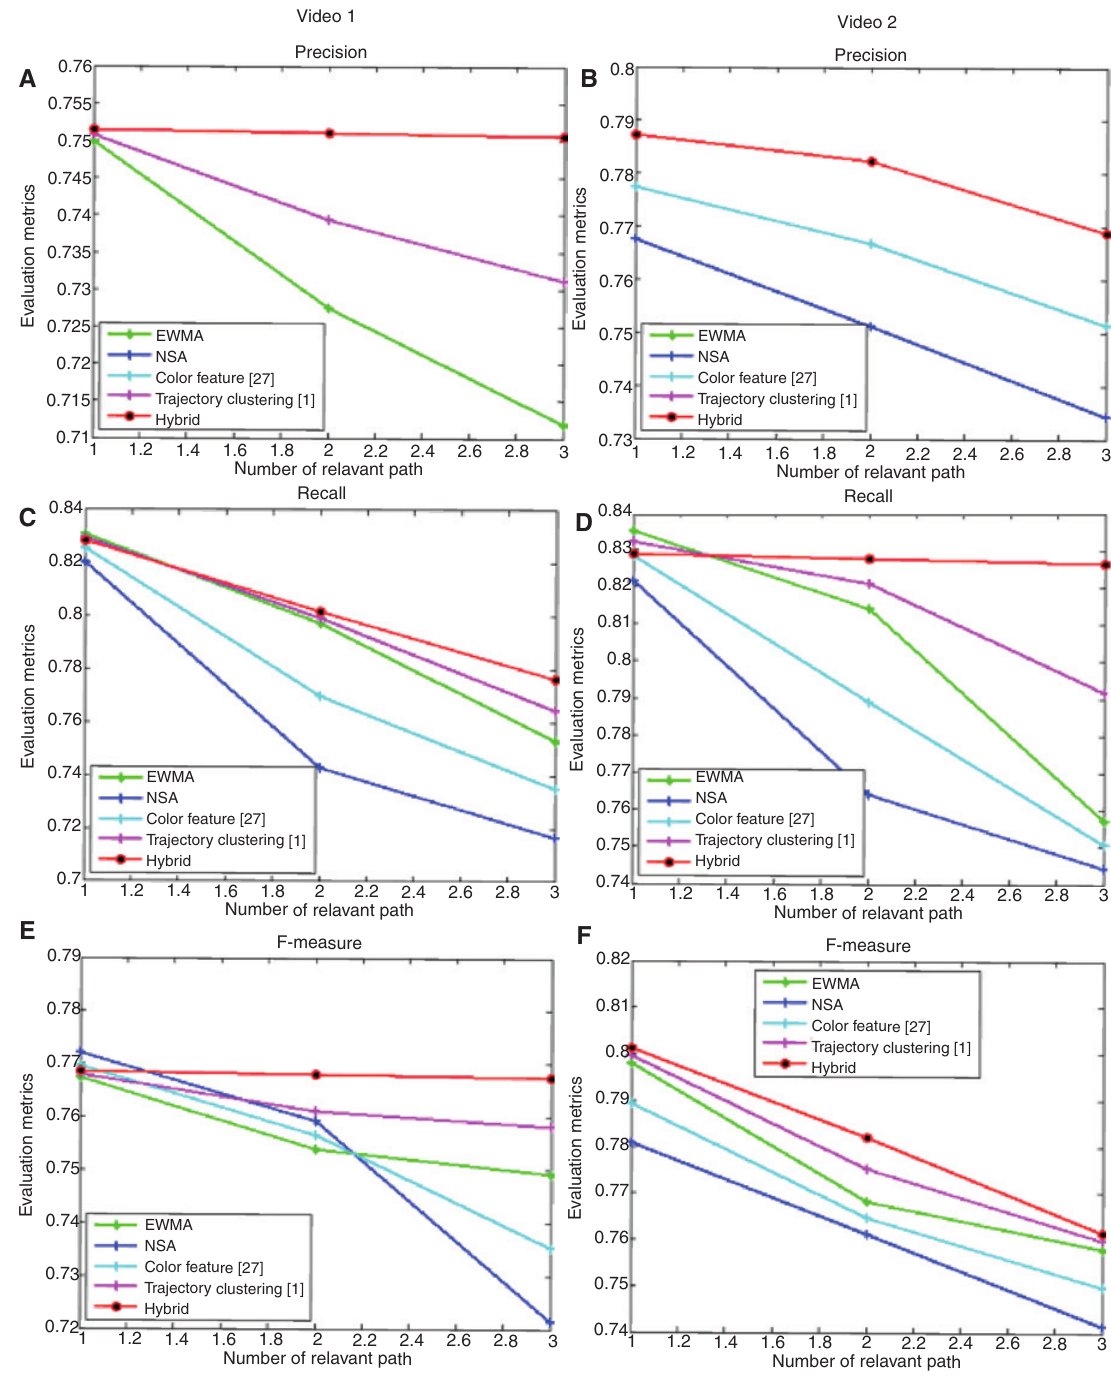
Figure 8: Performance Analysis of Video Object Retrieval for Video 1 and Video 2. (A) Video 1-Precision, (B) Video 2-Precision, (C) Video 1-Recall, (D) Video 2-Recall, (E) Video 1-F-measure, (F) Video